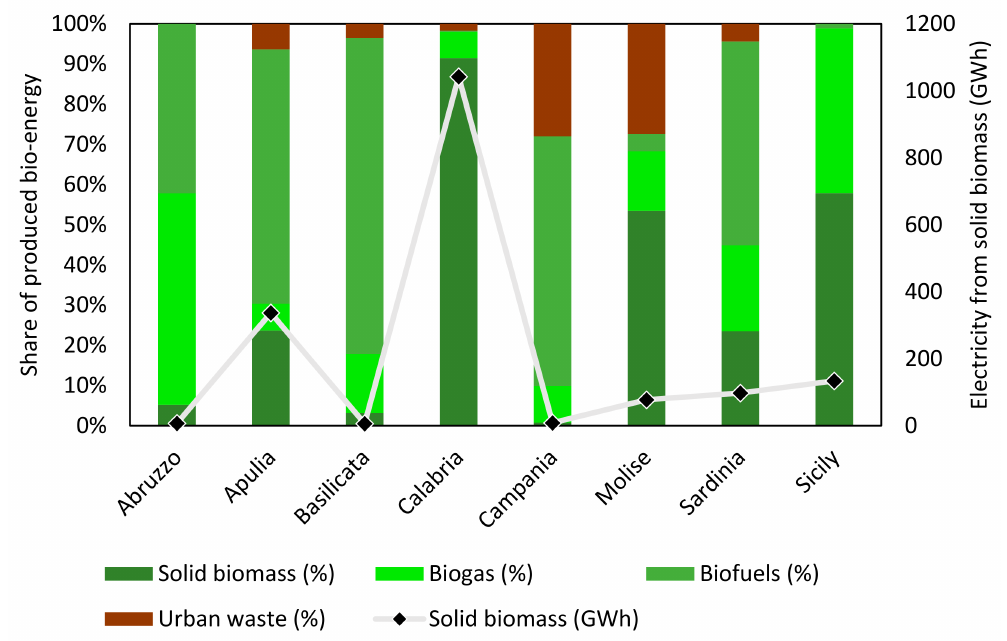
Figure 5. Source of bio-electricity in Southern Italy (data adapted from [54] by Terna spa,